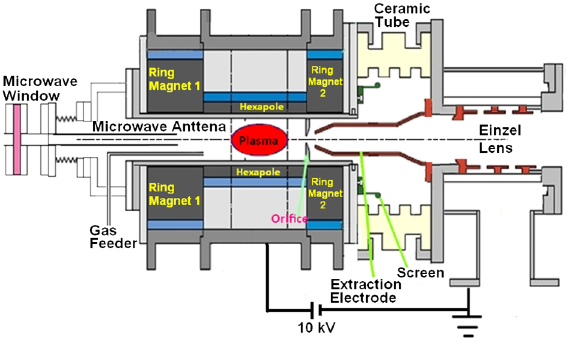
FIG. 2. Schematic view of KEK-DA